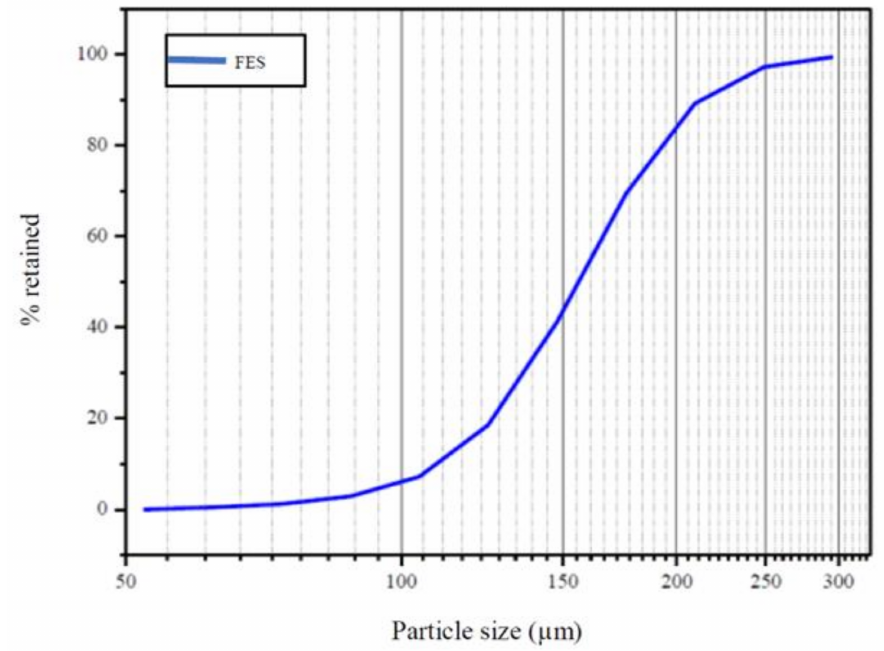
Figure 2. Waste foundry exhaust sand particle size distribution.